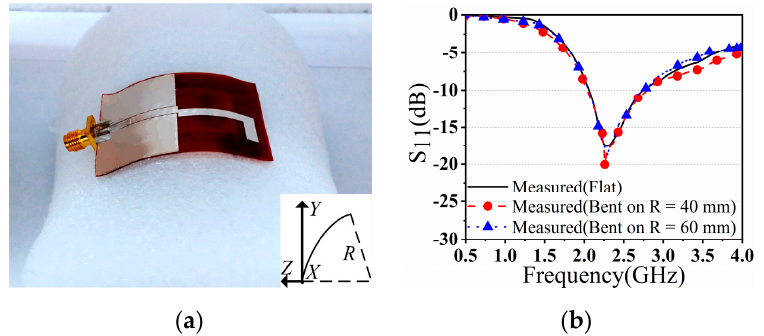
Figure 8. ( a ) Photograph. ( b ) Measured reflection coefficients under the flat and bending states.